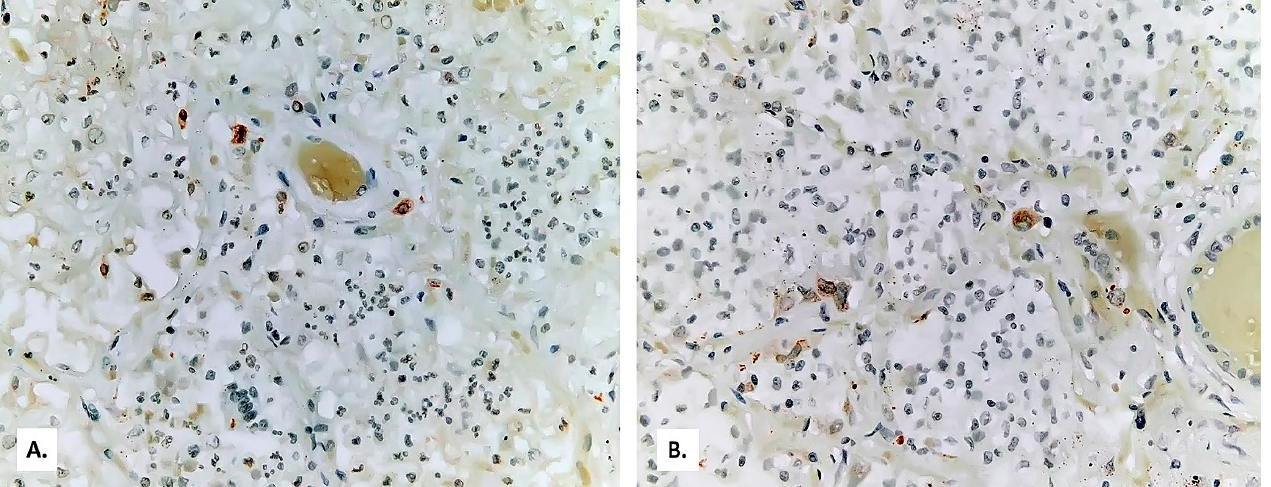
Figure 9. Immunolabeling for iNOS positive only in some macrophages (( A ) microscopic field 1; ( B ) microscopic field 2).